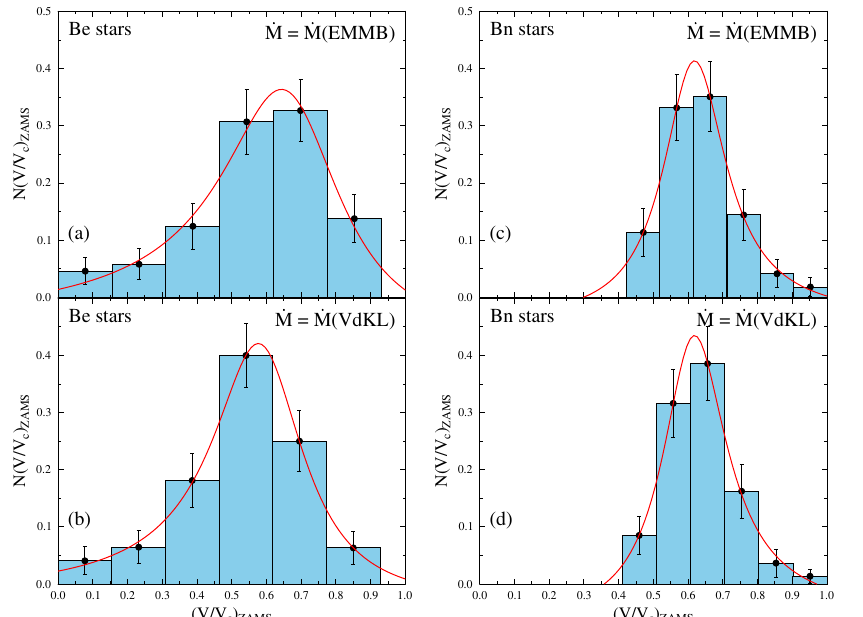
Figure 40. Normalized histograms showing the distribution of V / V c ratios in the ZAMS derived for Be (panels a , b ) and Bn (panels c , d ) stars. The results shown in panels a and c were obtained with EMMB mass-loss rates, while in panels b , d , the results are for VdKL mass-loss rates. Error bars indi- cate sampling uncertainties according to the errors associated with the measured V sin i parameters. Fitted Pearson distributions are superimposed (red curves) to better perceive the differences in the asymmetries (skewness) of distributions for each type of stars. Adapted from Cochetti et al.